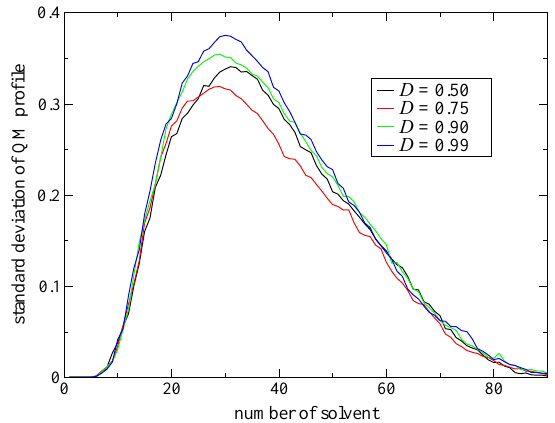
Figure 4. Standard deviations of instantaneous QM profiles, ω t , obtained from 100 ps SCMP simulations with 60 partitionings containing one QM solute water and 32 QM solvent water molecules. The horizontal axes represent the solvent number from the QM solute. Black, red, green and blue lines represent the results obtained by SCMP with degrees of order D = 0.50, 0.75, 0.90 and 0.99,